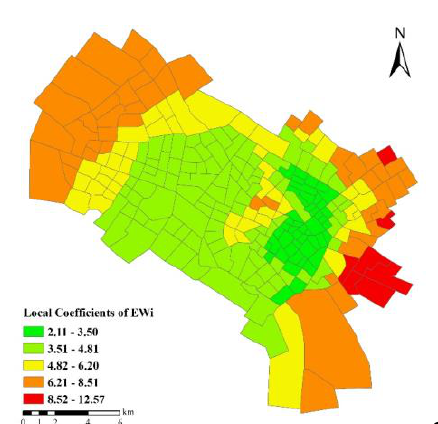
Figure 1. Local coefficients of EL i resulting from trip production models